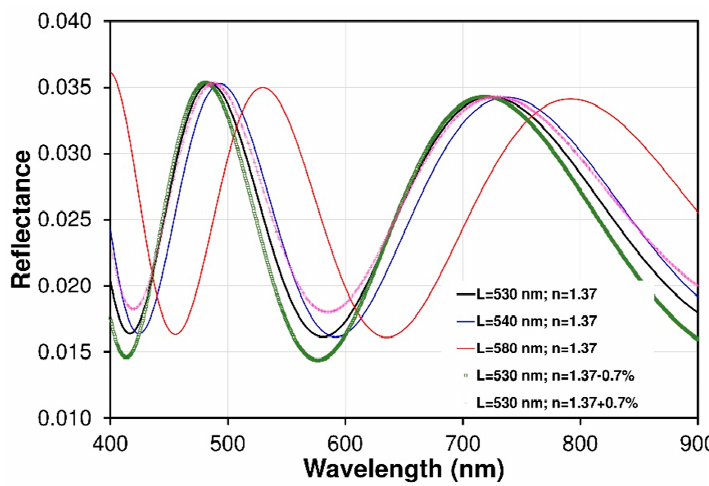
Figure 8. Comparison of the calculated interferograms for Nafion ® cavity with different patch length. The results show fringes shift effect and its contrast change due to cavity length and refractive index variation.